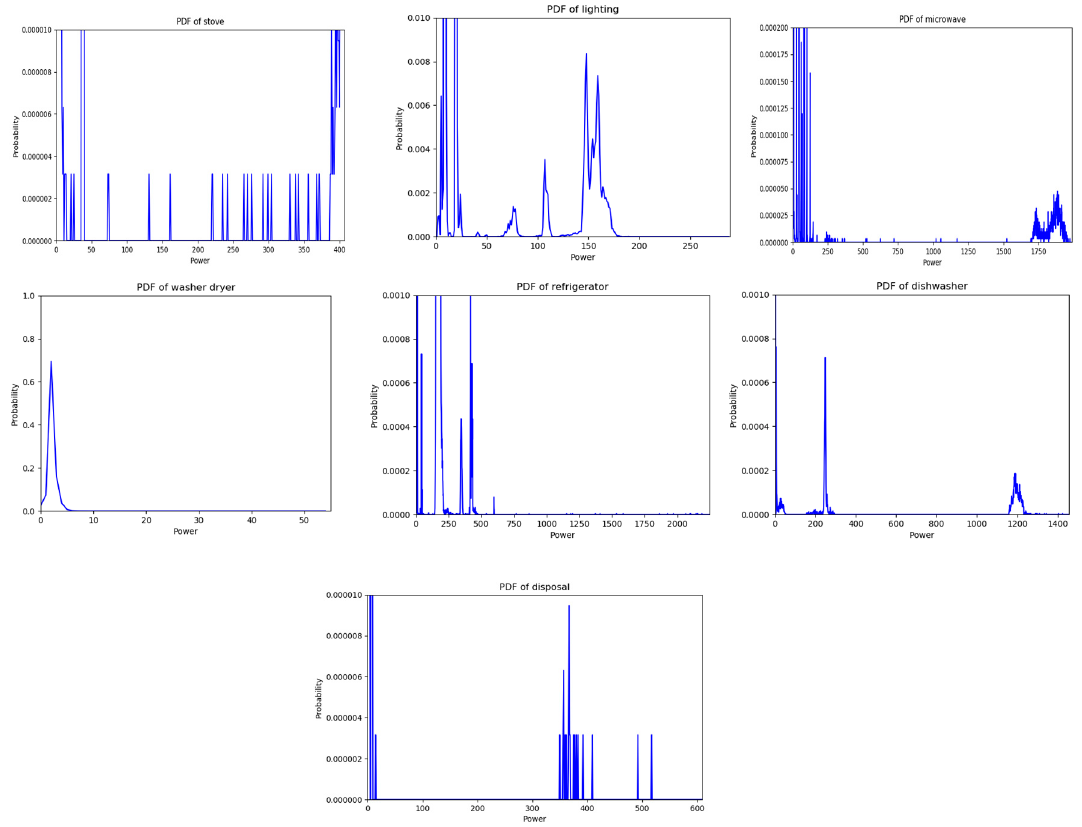
Figure 4. Power probability density function of some appliances in REDD house 2.